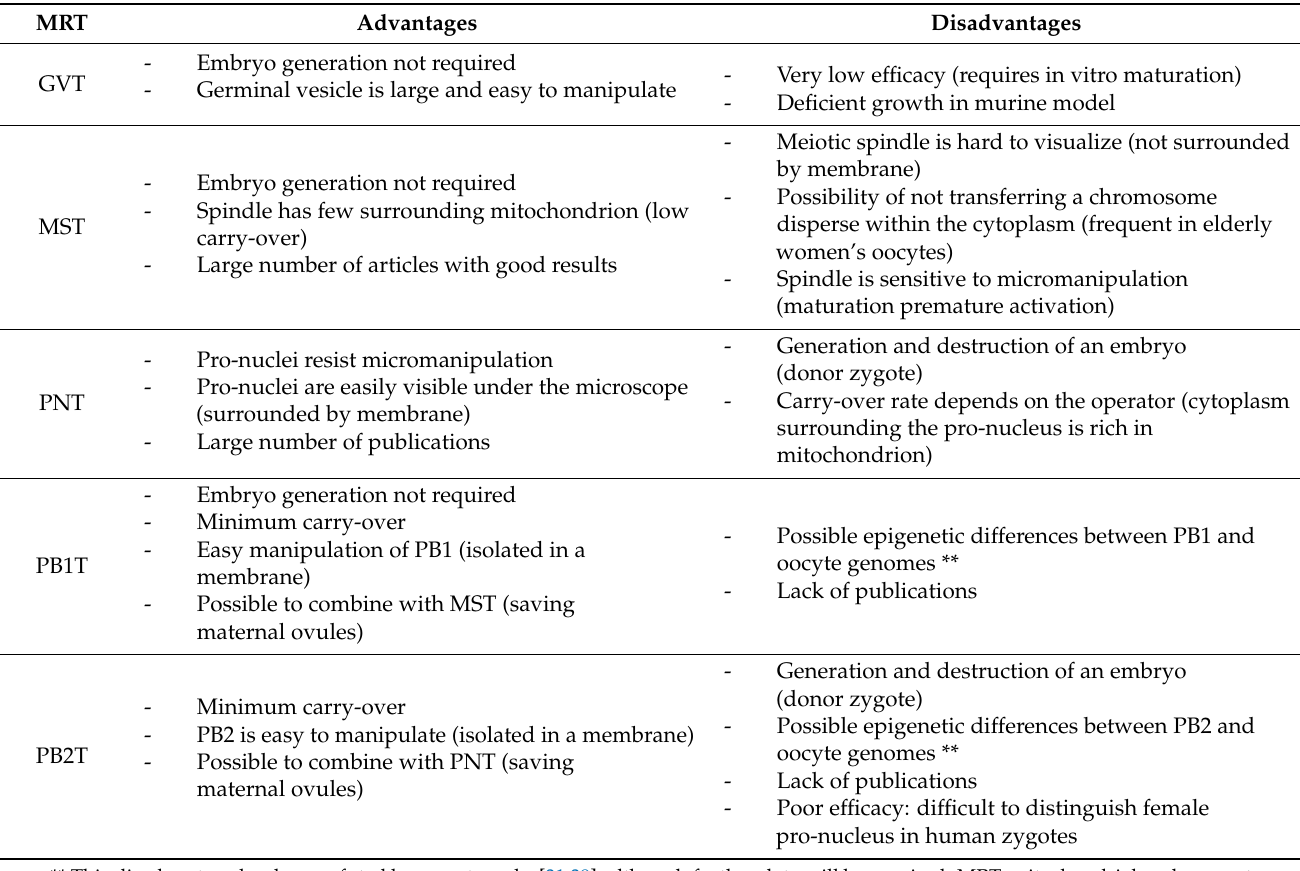
Table 8. Main advantages and disadvantages of